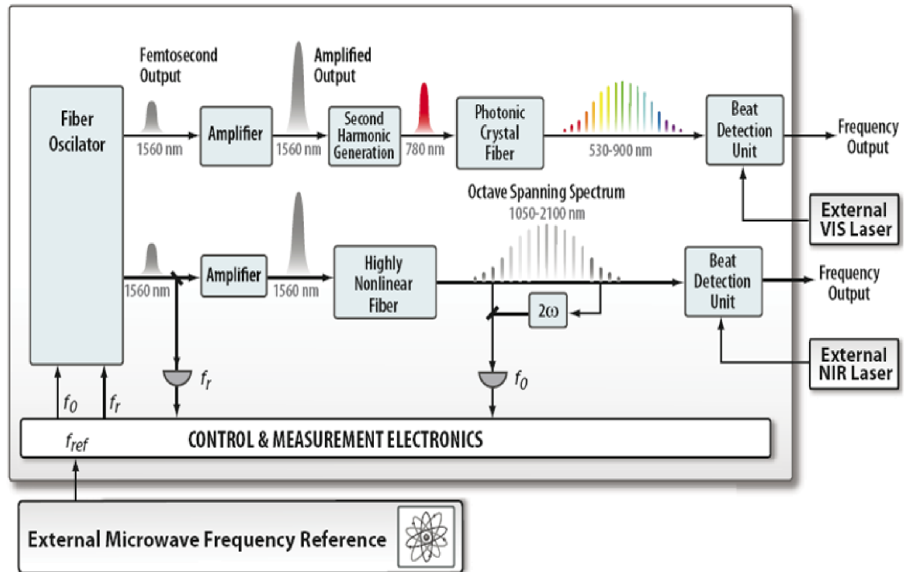
Fig. 3. Experimental setup used to measure the absolute frequency of different Zeeman-stabilized He – Ne lasers operating at 633nm with a femtosecond comb generator.